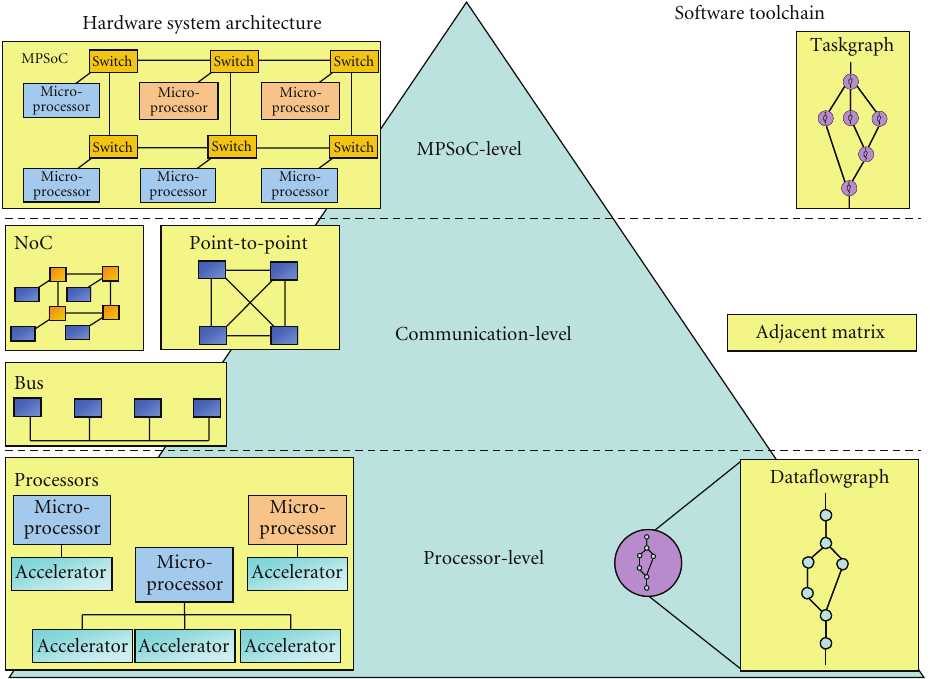
Figure 6: Three levels of hierarchy of